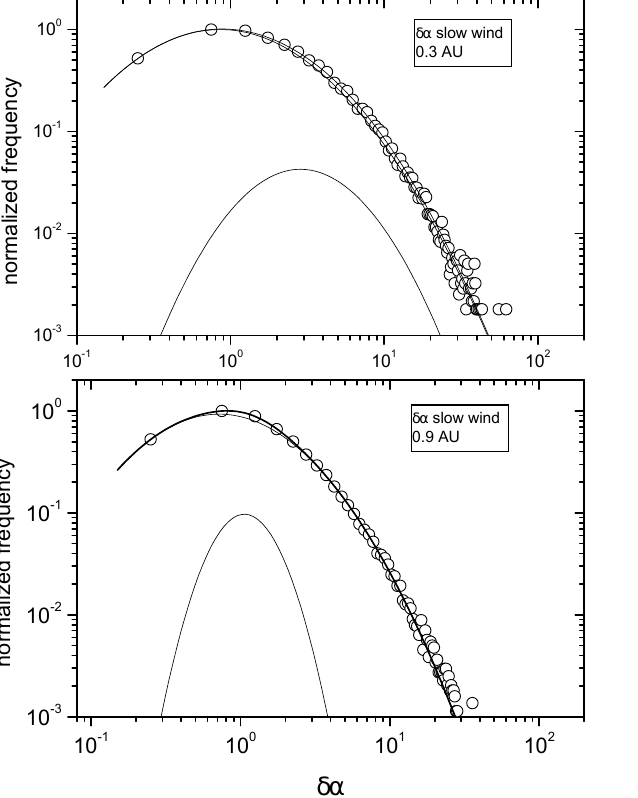
Fig. 11. PDFs of angular displacements δα at 0.3 and 0.9AU, for a slow wind, are shown in the top and bottom panels, respectively. The two thin solid curves refer to as many lognormals contributing to form the thick solid curve which best fit the distribution. Param- eters relative to the fit are reported in Table 5. Also in this case, the contribution of the smaller lognormal to the final fit is negligible.